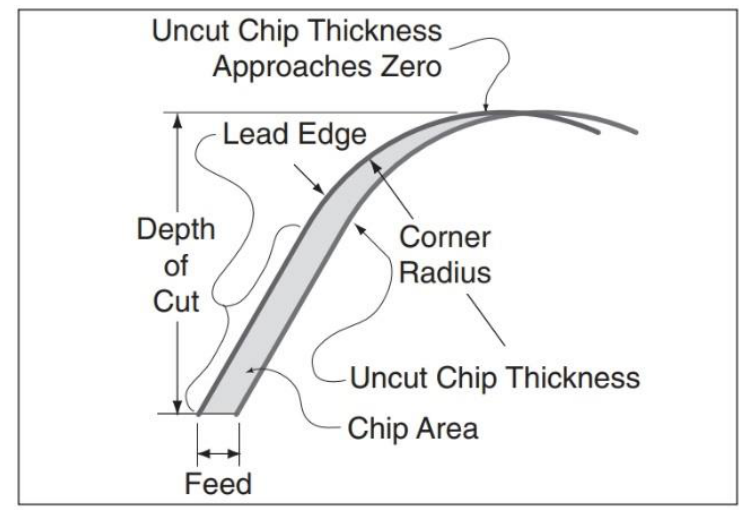
Figure 4. Tooth geometry and uncut chip thickness variation for corner-radiused tools [5].